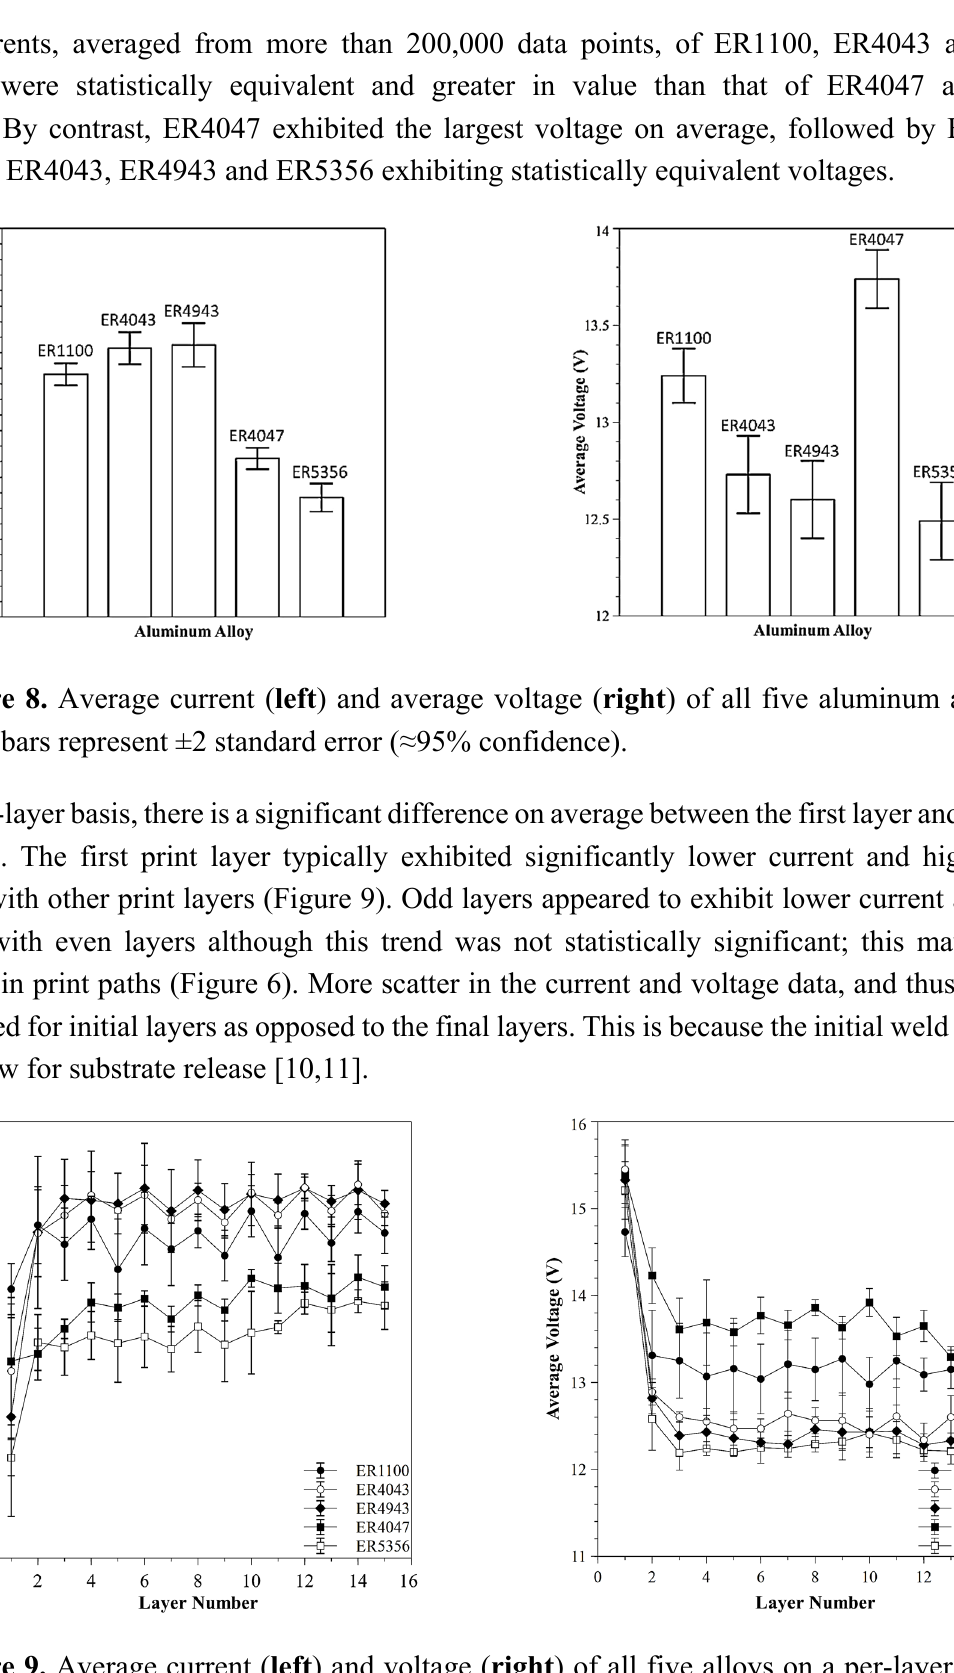
Figure 9. Average current ( left ) and voltage ( right ) of all five alloys on a per-layer basis. Error bars represent ±2 standard